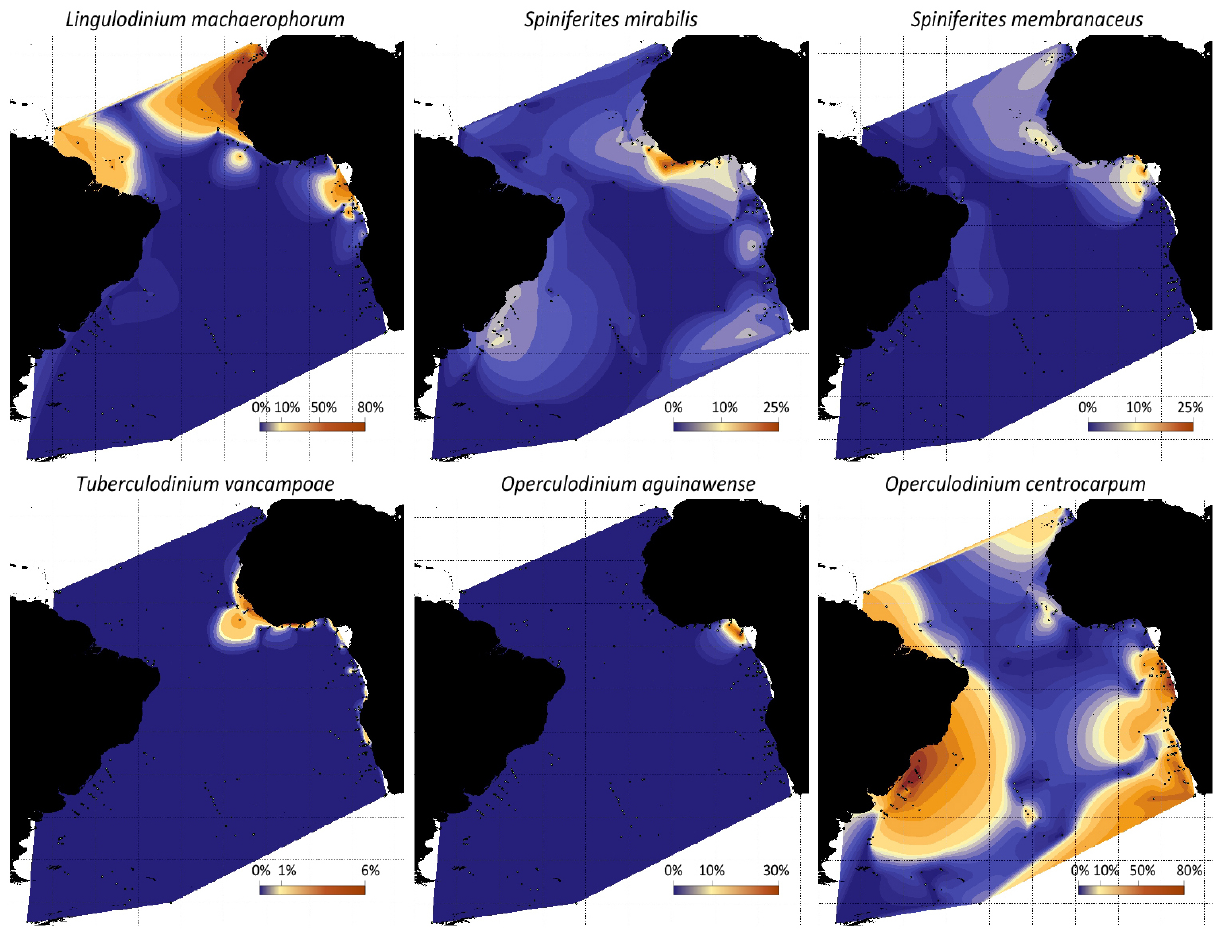
Figure 6. Present-day distribution of selected dinocyst taxa among major ones discussed in the paper. Percentages from 277 sites are extracted from the modern dinocyst atlas (Marret et al., 2008; Zonneveld et al.,